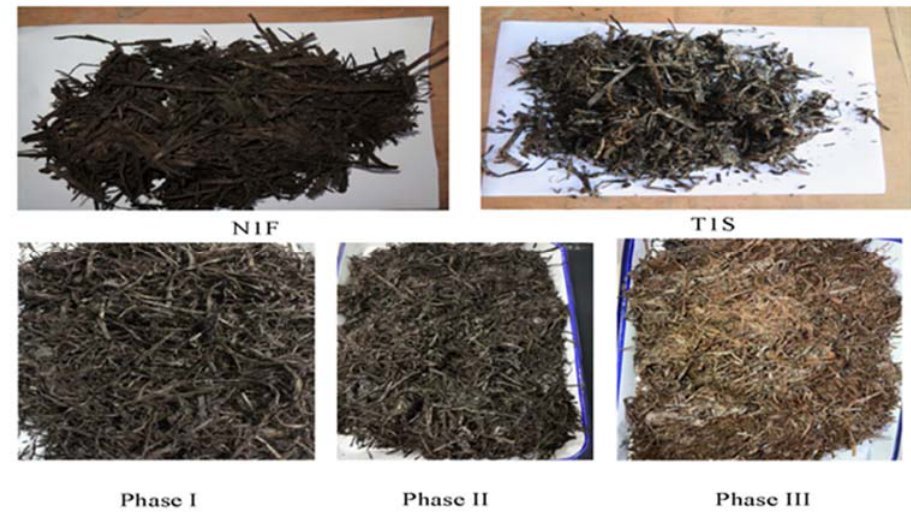
Figure 1. Fermentation Samples: Samples in each tunnel of the tertiary fermentation method and the secondary fermentation method.